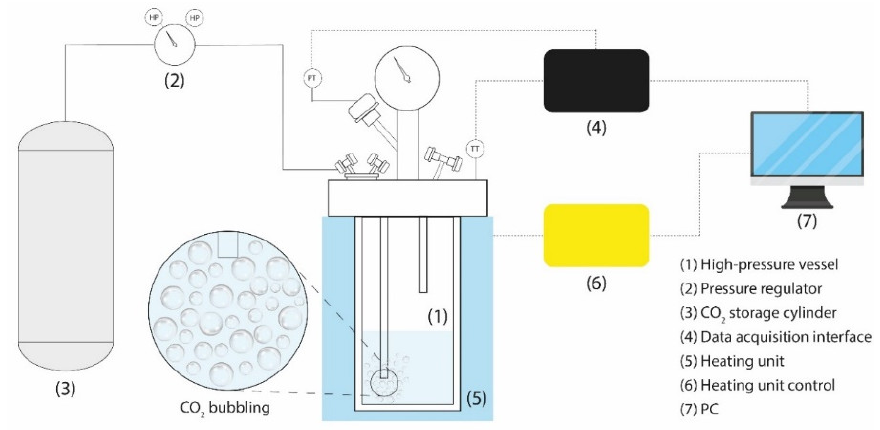
Figure 1. Schematic diagram of the high-pressure setup.